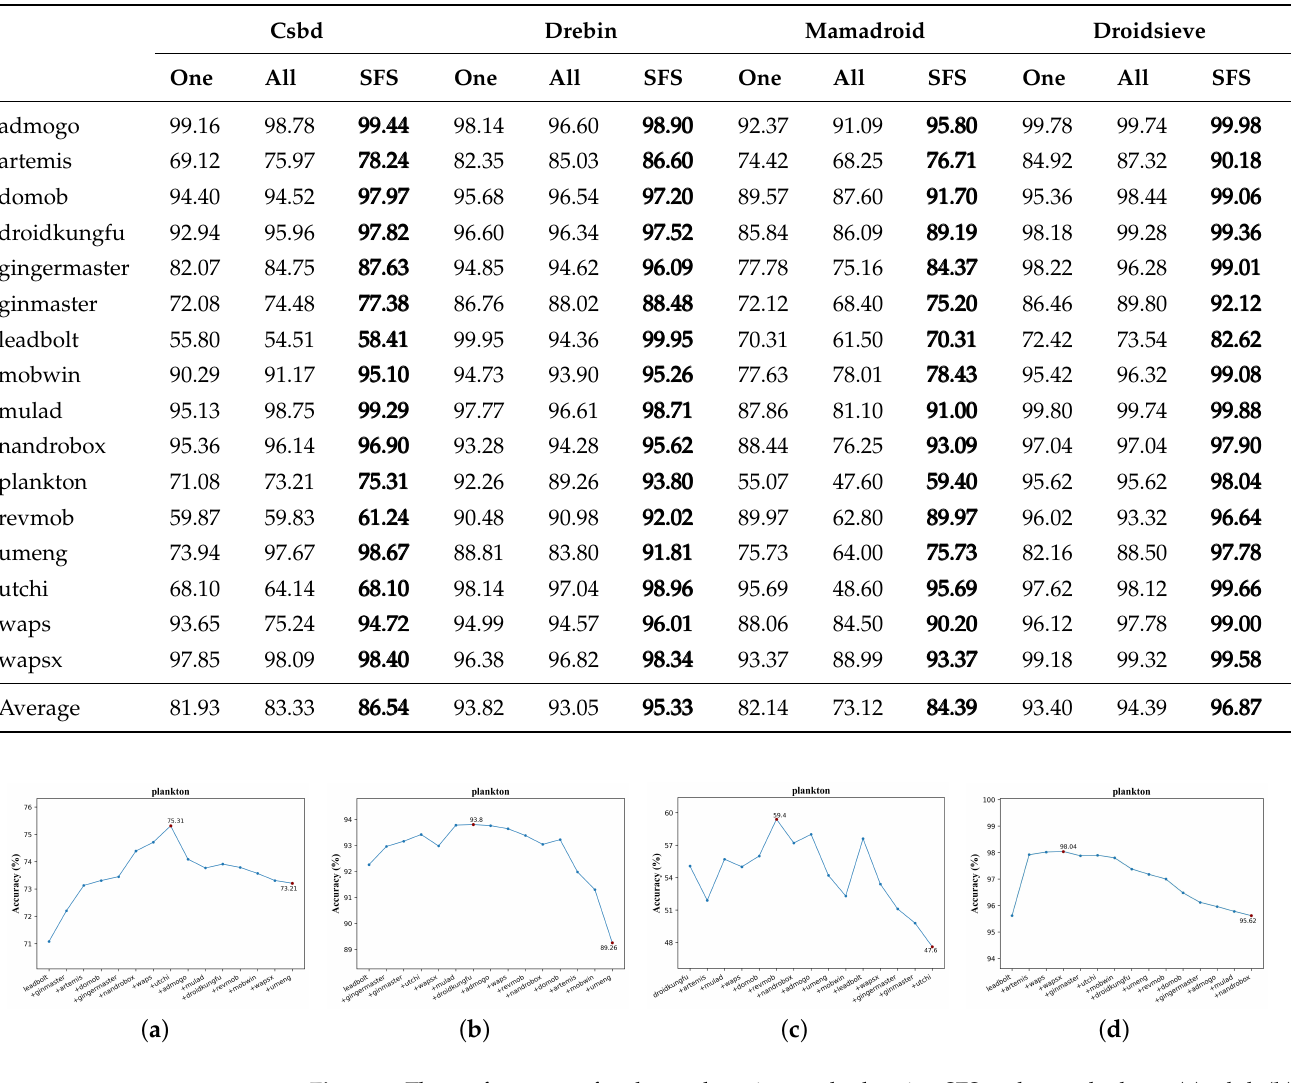
Figure 2. The performance of malware detection methods using SFS to detect plankton. ( a ) csbd. ( b ) drebin. ( c ) mamadroid. ( d )